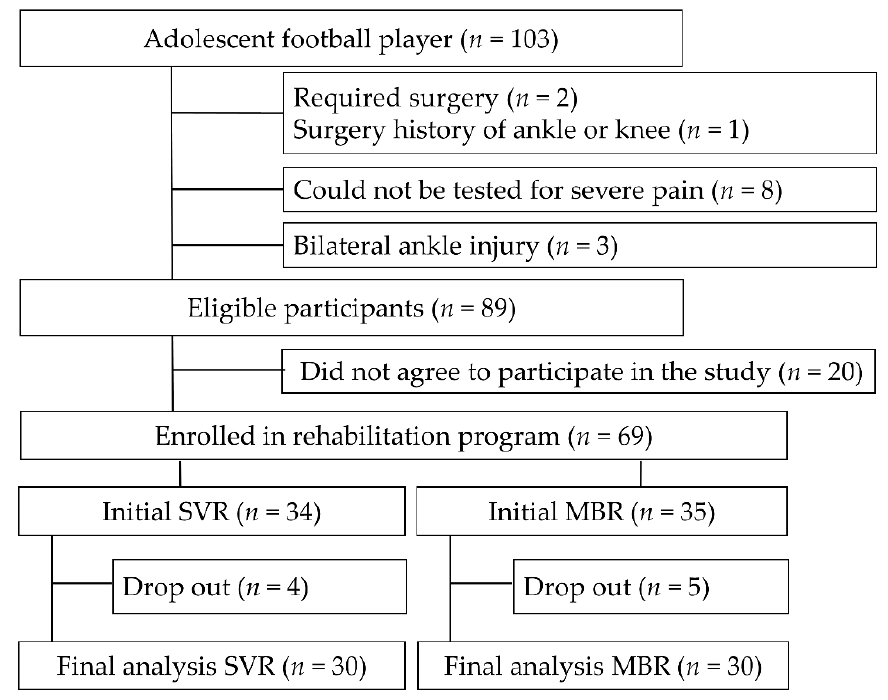
Figure 1. Schema illustrating study flow.